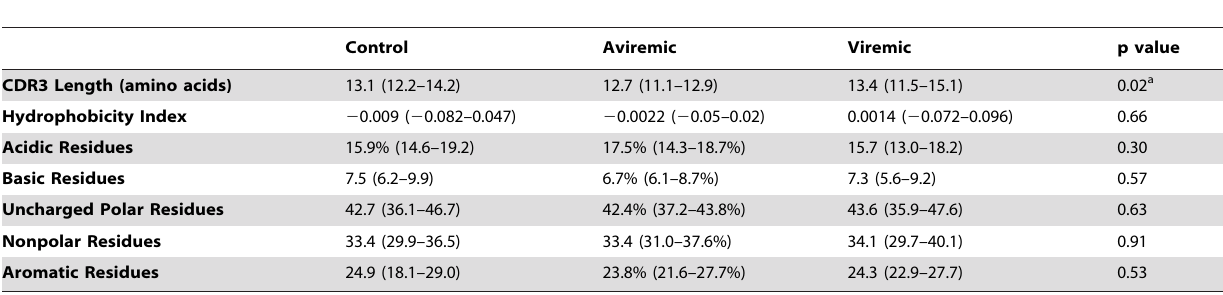
Table 2. Biochemical characteristics of amino acids in the CDR3 regions in HIV-1-infected and control subjects.